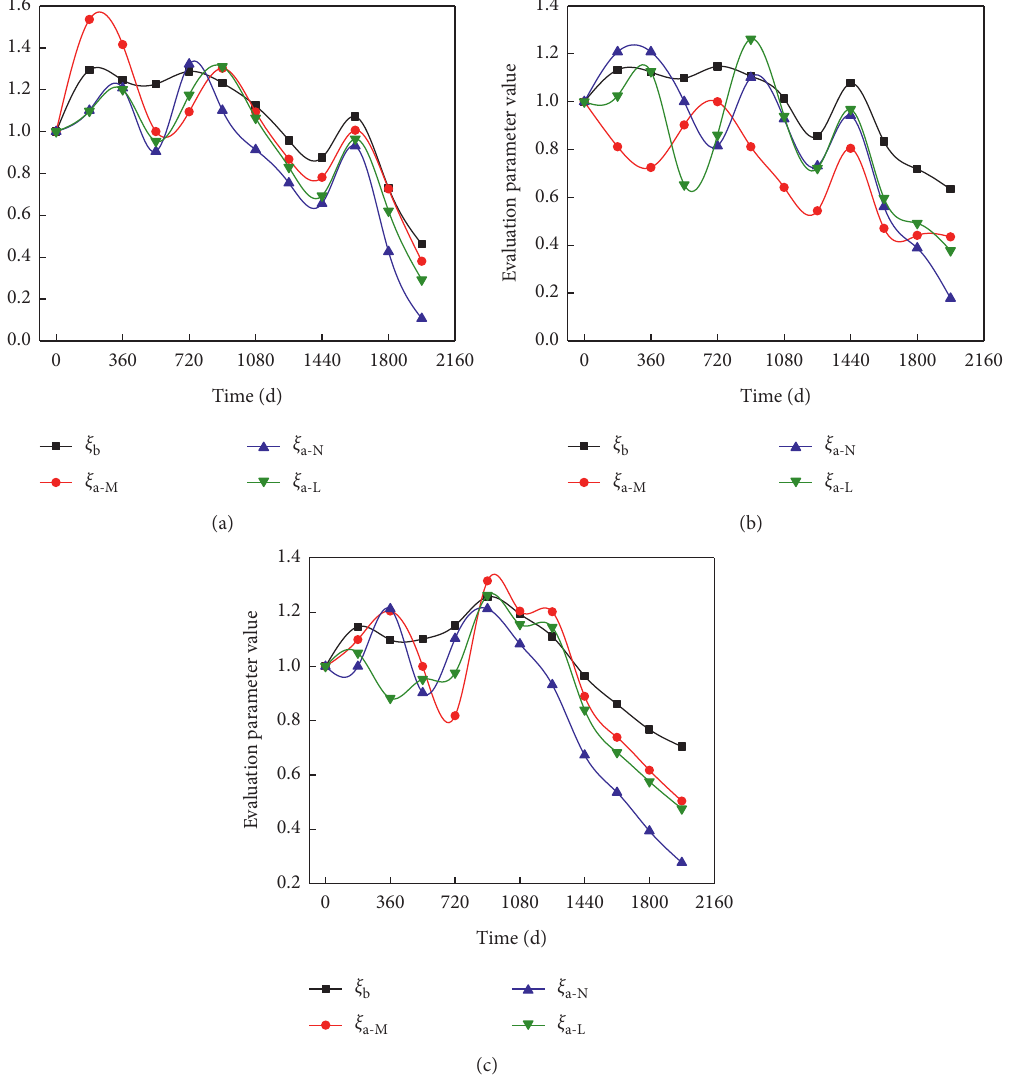
Figure 3: Durability evaluation parameters of concrete with different strength grades. (a) C30 Concrete. (b) C40 Concrete. (c) C50